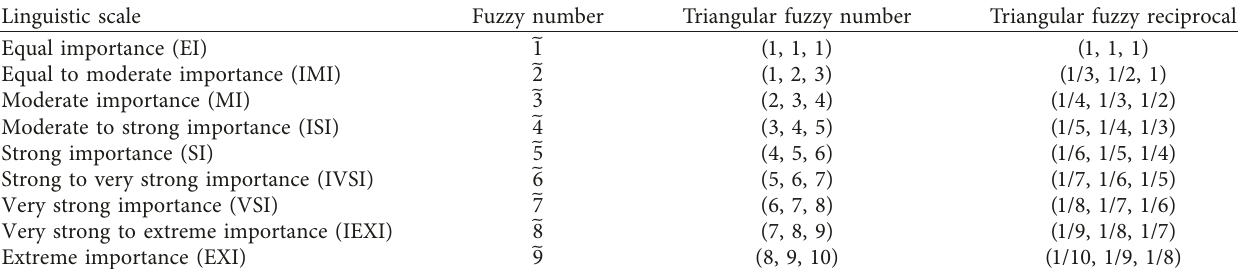
Table 1: Linguistic variables and triangular fuzzy numbers.